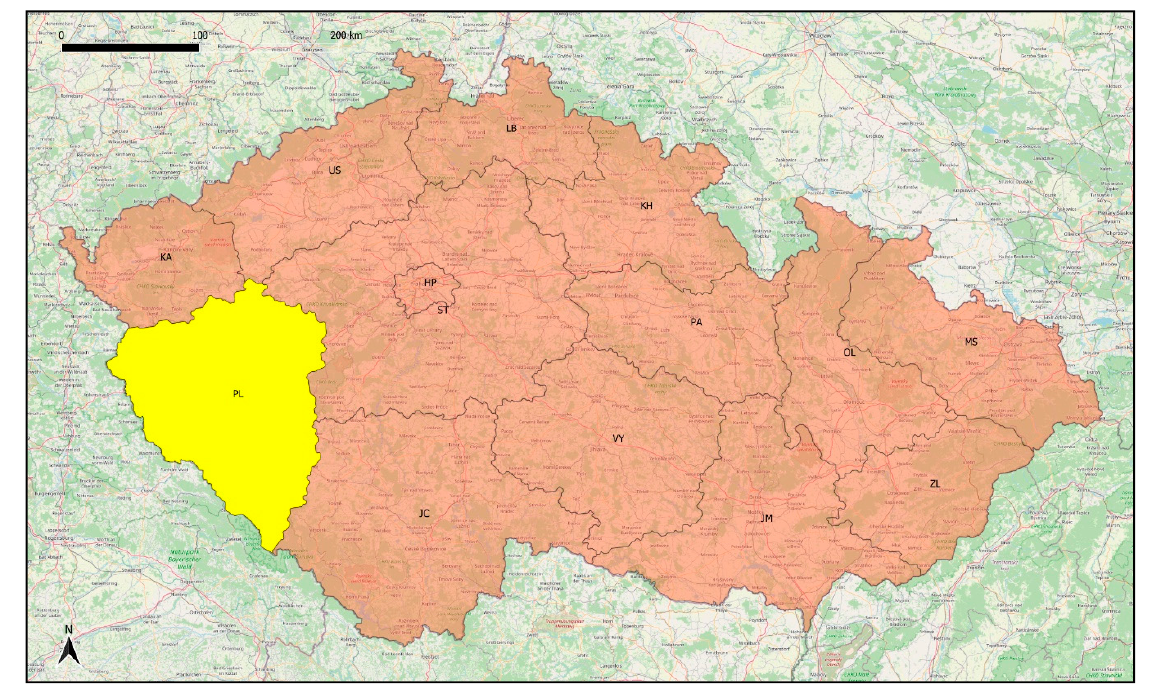
Figure 2. Regions of the Czech Republic with the highlighted Pilsen region in yellow.